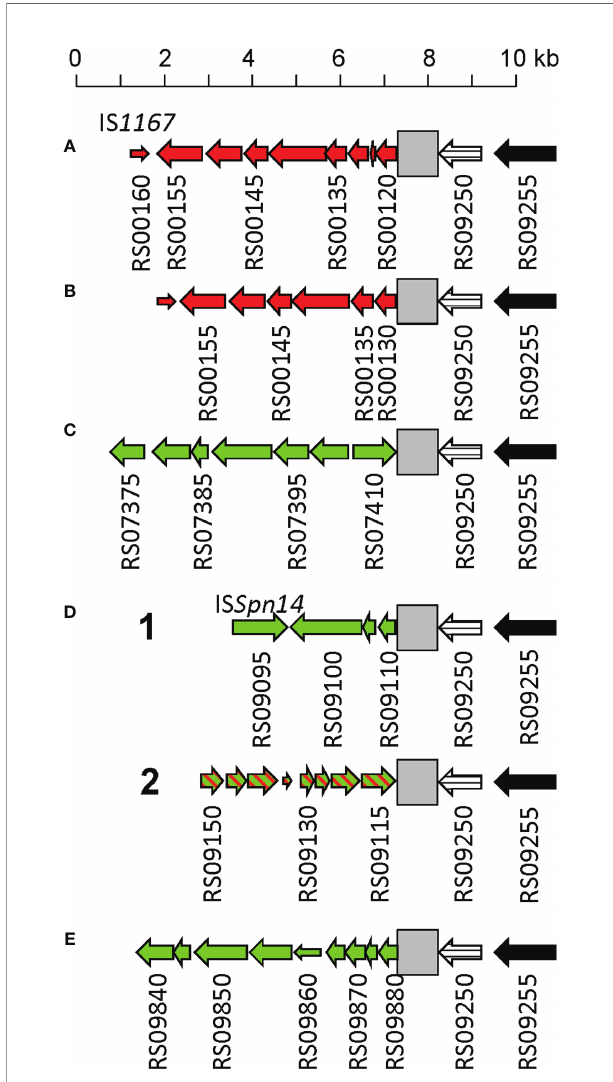
FIGURE 5 | Schematic representation of several DNA rearrangements in the 3 ’ region of lytA Spn *. Genes are represented as arrows indicating the direction of transcription and are numbered as those of the S. pneumoniae D39 strain (SPD_). Narrow open arrows indicate frameshifted open reading frames. The lytA Spn gene (SPD_RS09250) is represented by a striped arrow. Panels (A – E) respectively show the rearrangements of genes located in the vicinity of SPD_RS00120 (coding for a nucleoside deaminase), SPD_RS00125 ( ffs encoding the signal recognition particle sRNA), SPD_RS07415 ( whiA ), SPD_RS09110 (coding for a single-stranded DNA-binding protein), or within SPD_RS09885 (encoding ComGC, the major subunit of the competence pilus). Green and red arrows respectively indicate genes translocated or inverted with respect to their position in S. pneumoniae D39. In arrangement D2, an additional recombination event caused the inversion of several genes (indicated by hatched arrows). A gray square indicates the region located 3 ’ of lytA Spn shown in detail in Figure 6 a tandem duplication of a cluster of nine genes in PPH080_1A (marked with different colors in Figure S2 ). Further, some rare events related to PPH insertion were also noted. PPH075, PPH080_3, and PPH120 contained attB sequences, which would allow another phage to be integrated into their genomes, forming a